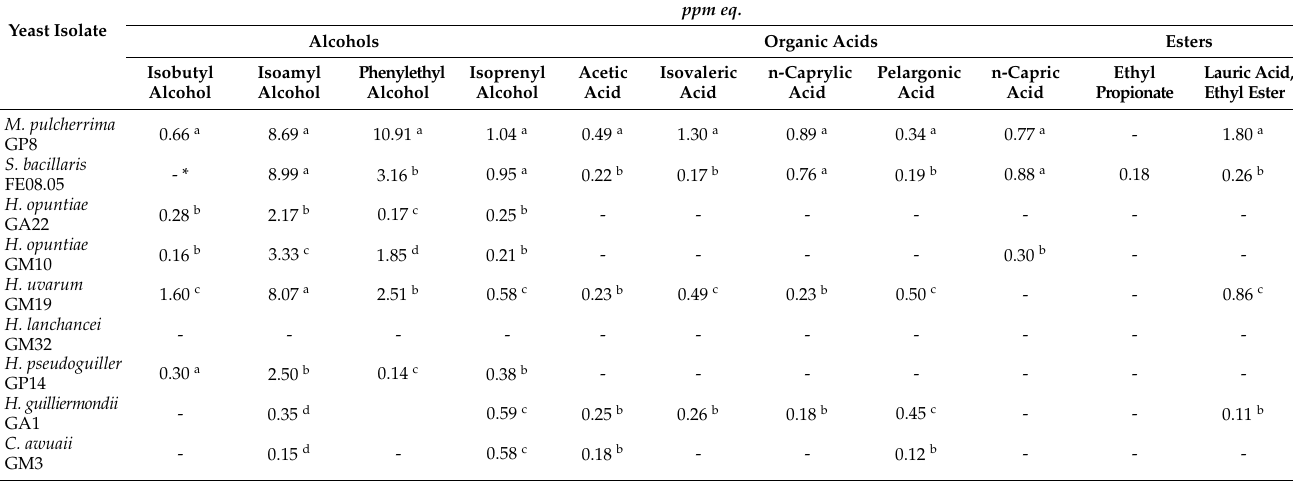
Table 4. Volatile organic compounds (VOCs) produced by 6-day-old cultures of the selected strains with antifungal properties. Data are the mean of three replicates. Standard deviation observed ranged between 5 and 7%. Results are the mean of three replicates. For each compound considered, different letters indicate significantly ( p < 0.05) different amounts based on DUNCAN’s tests. ppm eq. Organic Acids